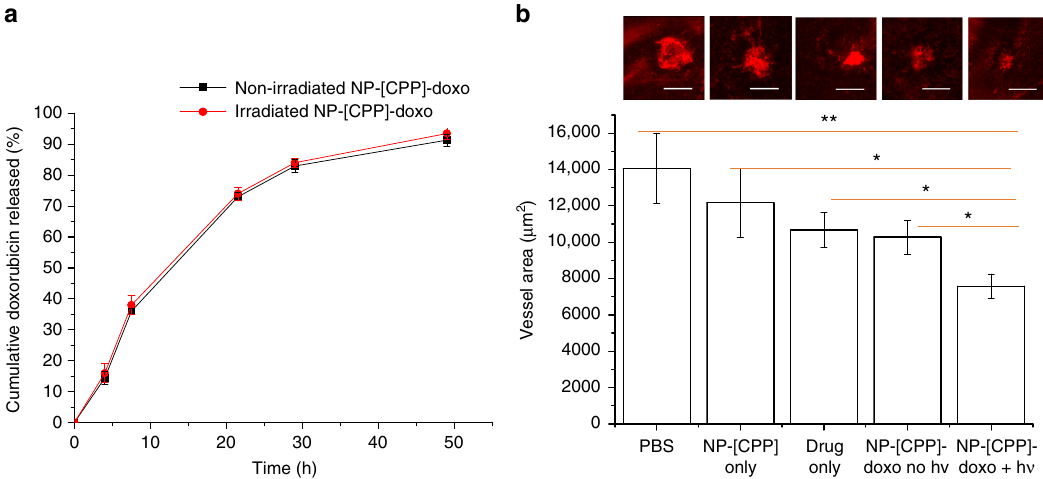
Fig. 5 Treatment with NP-[CPP]-doxo in mouse CNV model. a Cumulative doxorubicin release (as % of total amount loaded) from NP-[CPP]-doxo at 37 °C in vitro by dialysis, with or without irradiation (400 nm LED for 1 min at 50 mW cm − 2 ) at t = 0. Data are means ± SD ( n = 4 independent experiments). b Representative isolectin GS IB 4 -stained CNV images (the scale bar is 100 μ m) and mean CNV lesion area from laser-induced CNV mice treated with PBS, NP-[CPP], doxo, NP-[CPP]-doxo, and NP-[CPP]-doxo with irradiation. Error bars show standard error of the mean. n = 28 lesions. * P < 0.05, ** P < 0.005 (unpaired t -test). (See Supplementary Fig. 14 for graph of individual data points and Supplementary Table 1 for the standard